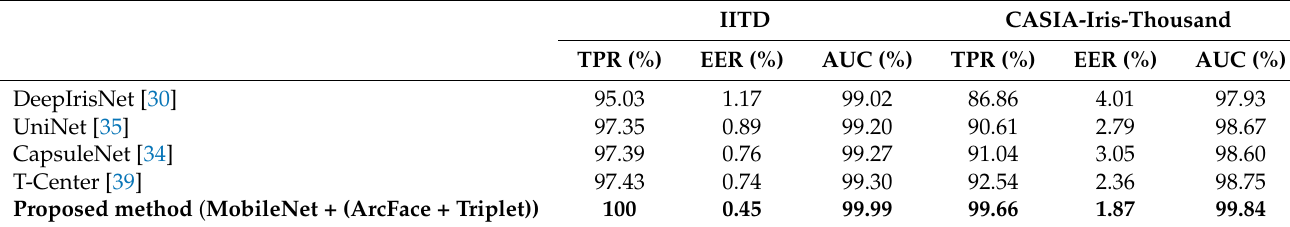
Table 4. Comparison of the performance on two public